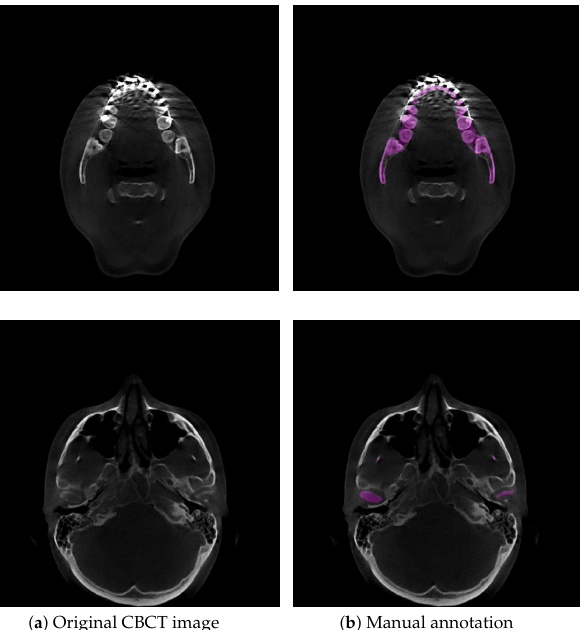
Figure 1. Example illustrations that challenge mandible segmentation in CBCT images. ( a ) Original CBCT image. The mandible and teeth appear with almost invisible boundaries. ( b ) Example of manual annotation. Low contrast often appears in condyles. The purple region indicates the manual annotation of the